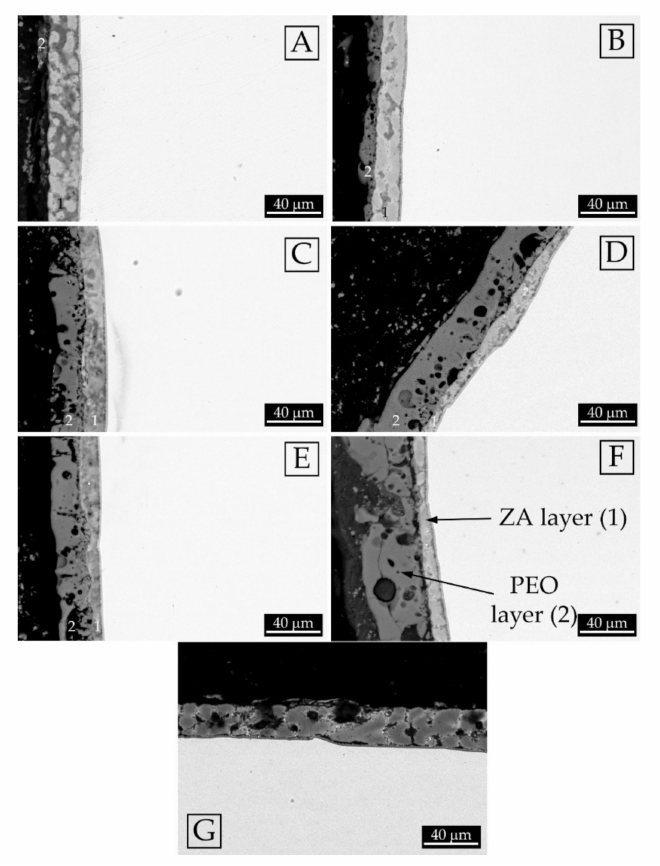
Figure 2. SEM images (backscattered electrons mode) of the cross sections of the di ff erent samples: ( A ) Sample treated at 1.1 A / cm 2 for 2 min; ( B ) Sample treated at 1.1 A / cm 2 for 3 min; ( C ) Sample treated at 1.7 A / cm 2 for 2 min; ( D ) Sample treated at 1.7 A / cm 2 for 3 min; ( E ) Sample treated at 2.3 A / cm 2 for 2 min; ( F ) Sample treated at 2.3 A / cm 2 for 3 min; ( G ) Sample with only the ZA layer In the micrographs the number (1) indicates the inner ZA layer and the number (2) the external PEO